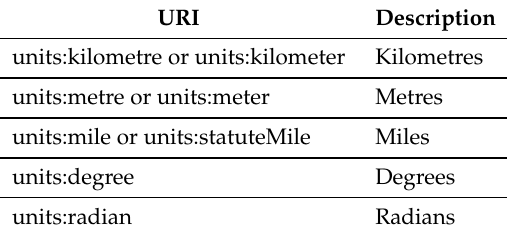
Table 3. Supported